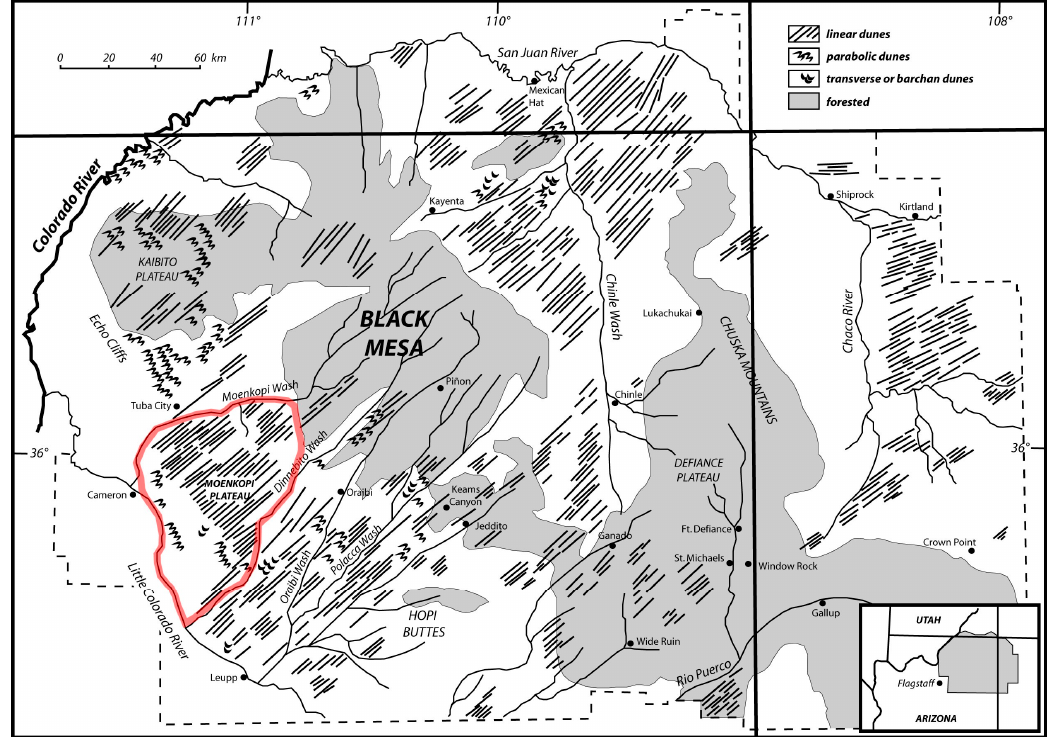
Figure 1. Distribution of aeolian landforms and forested areas of the Navajo Nation and Hopi Lands as mapped by J.T. Hack (1941). The study area is outlined in red.